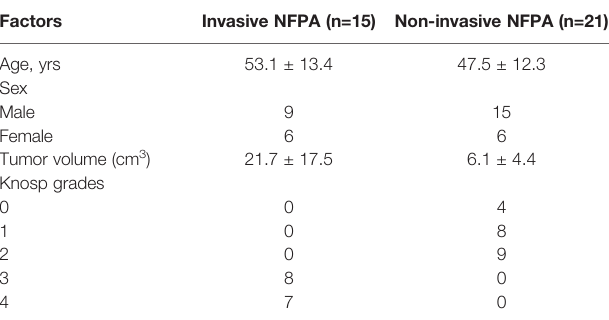
TABLE 1 | Patient ’ s characteristics in invasive and non-invasive